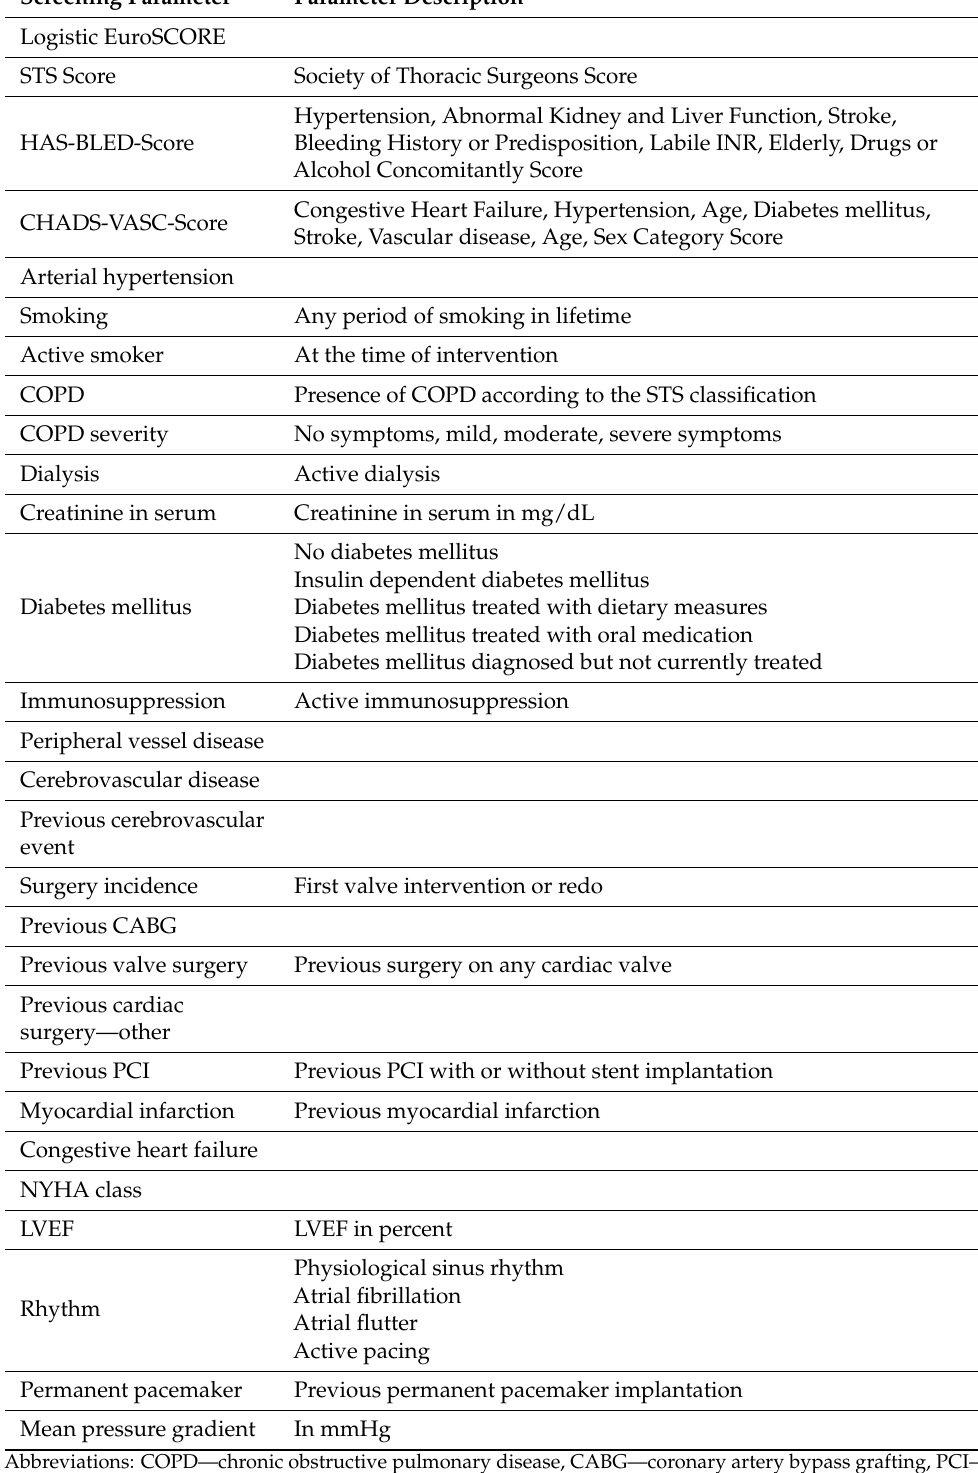
Table 1. Cont. Screening